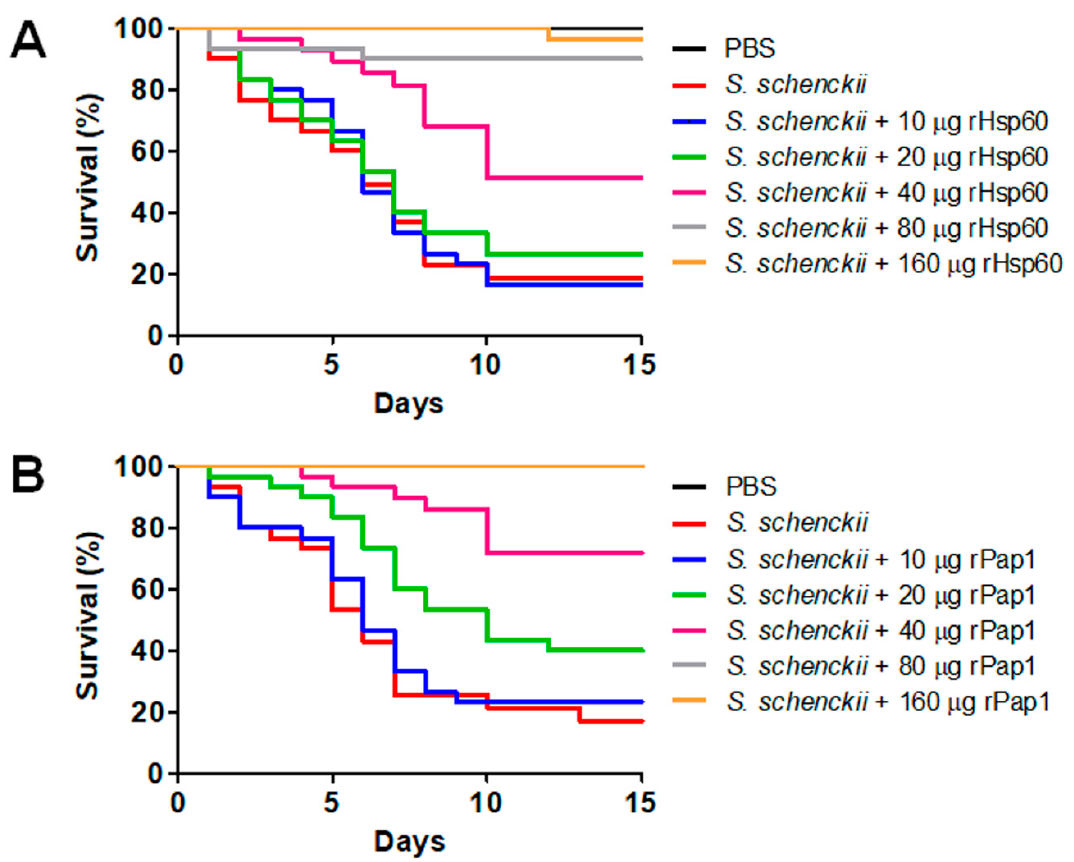
Figure 5. Effect of recombinant Hsp60 and Pap1 on the Galleria mellonella killed by Sporothrix schenckii. G. mellonella larvae were inoculated with either phosphate-buffered saline (PBS) or the indicated amount of rHsp60 ( A ) or rPap1 ( B ) and incubated for 5 days at 37 °C. Then, a lethal S. schenckii inoculum of 1 × 10 5 yeast-like cells was injected into larvae, which were kept at 37 °C, and mortality was recorded daily. PBS, control group inoculated and challenged with PBS. S. schenckii , animal group inoculated with PBS and challenged with 1 × 10 5 yeast-like cells.